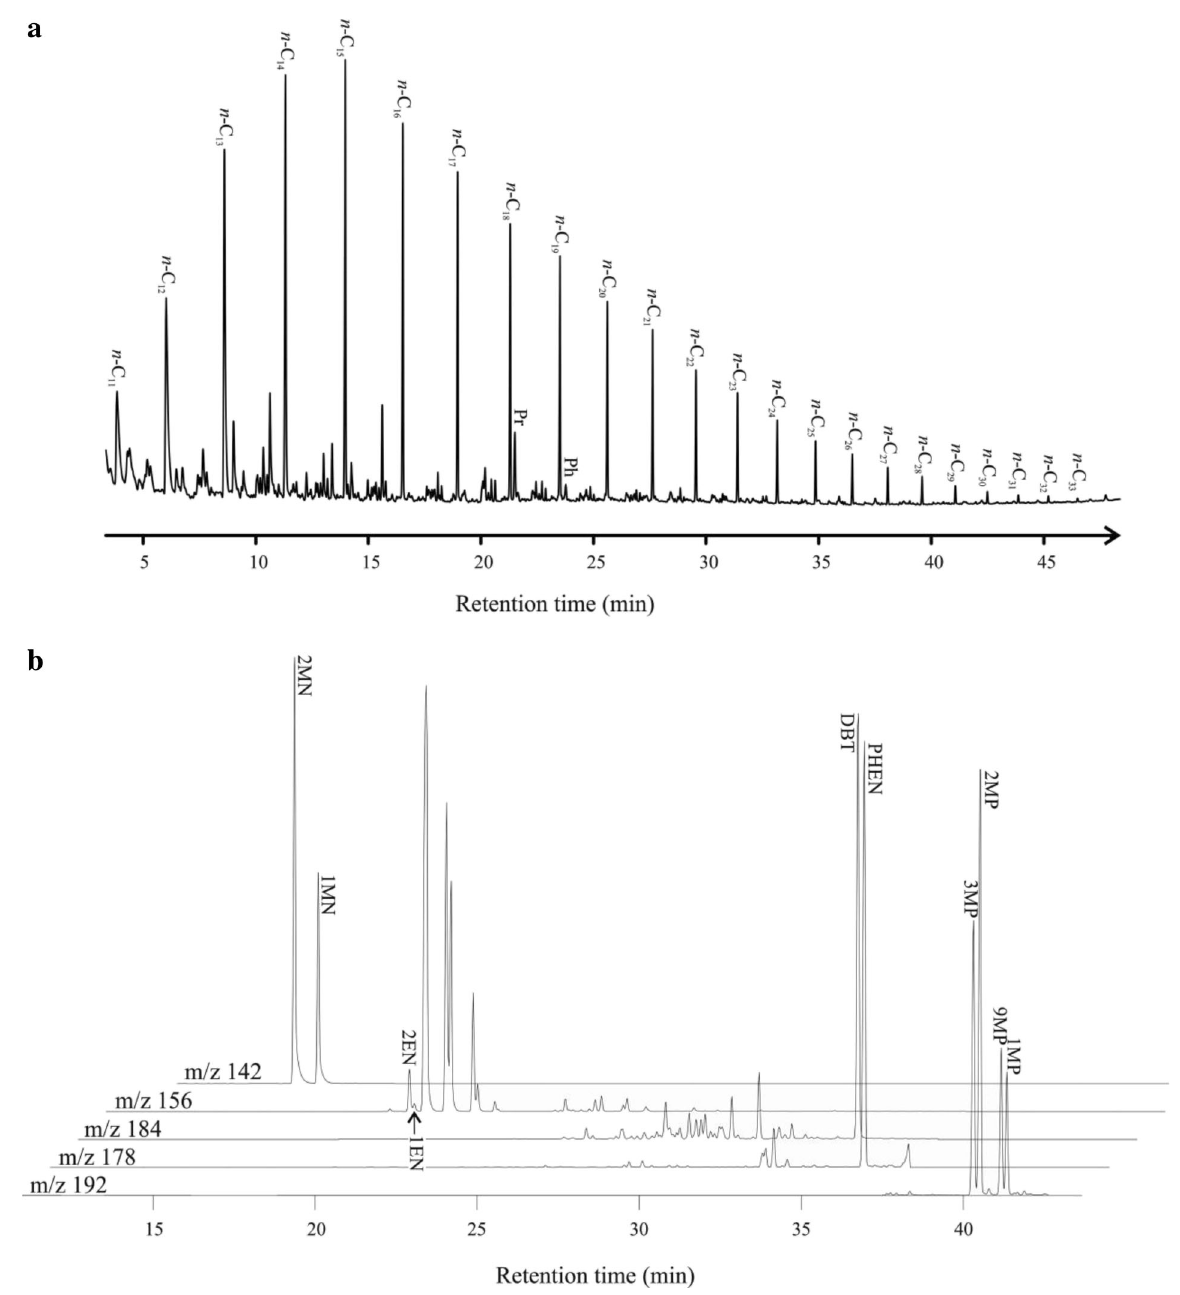
Fig. 5 a Representative GC–FID chromatogram of saturated hydrocarbons showing the distribution of n - and iso -alkanes in sample 17/2017 from the Parvadeh coalfield, b M / z 142, 156, 184, 178 and 192 mass fragmentograms of the aromatic fraction extracted from the same